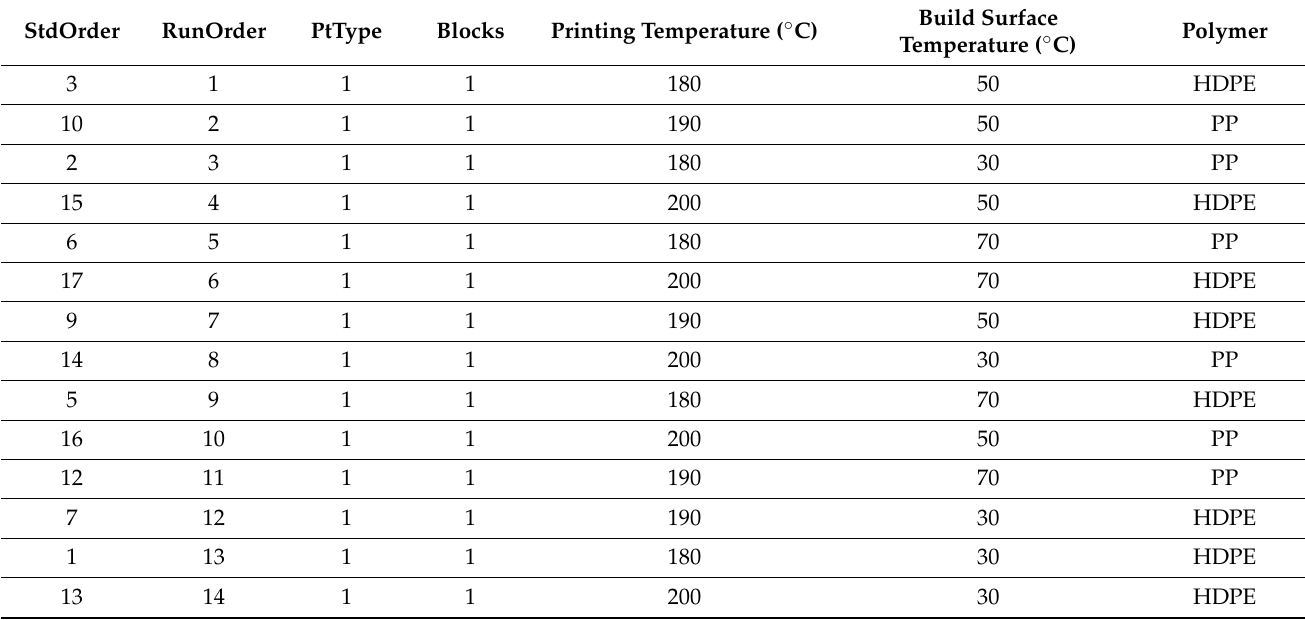
Table 2. Mixed level general full factorial design of experiments with